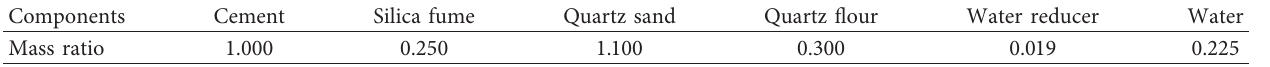
Table 4: UHPC mix proportion.